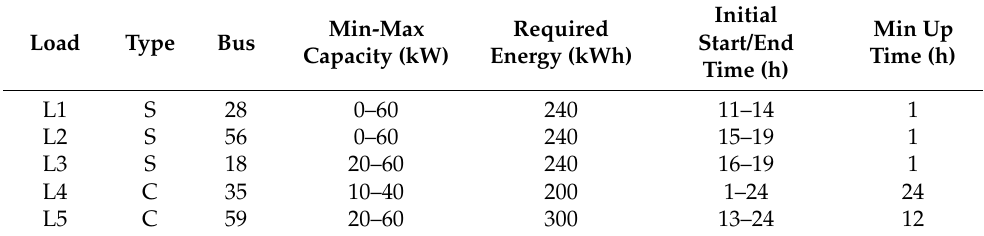
Table 5. Characteristics of adjustable loads (s: shiftable, c: